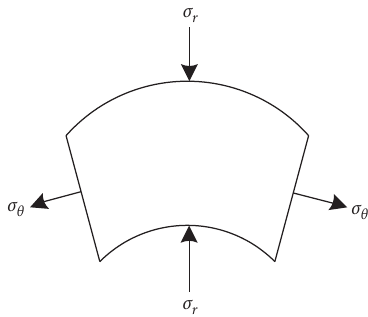
Figure 1: Stress state at any point in the rock